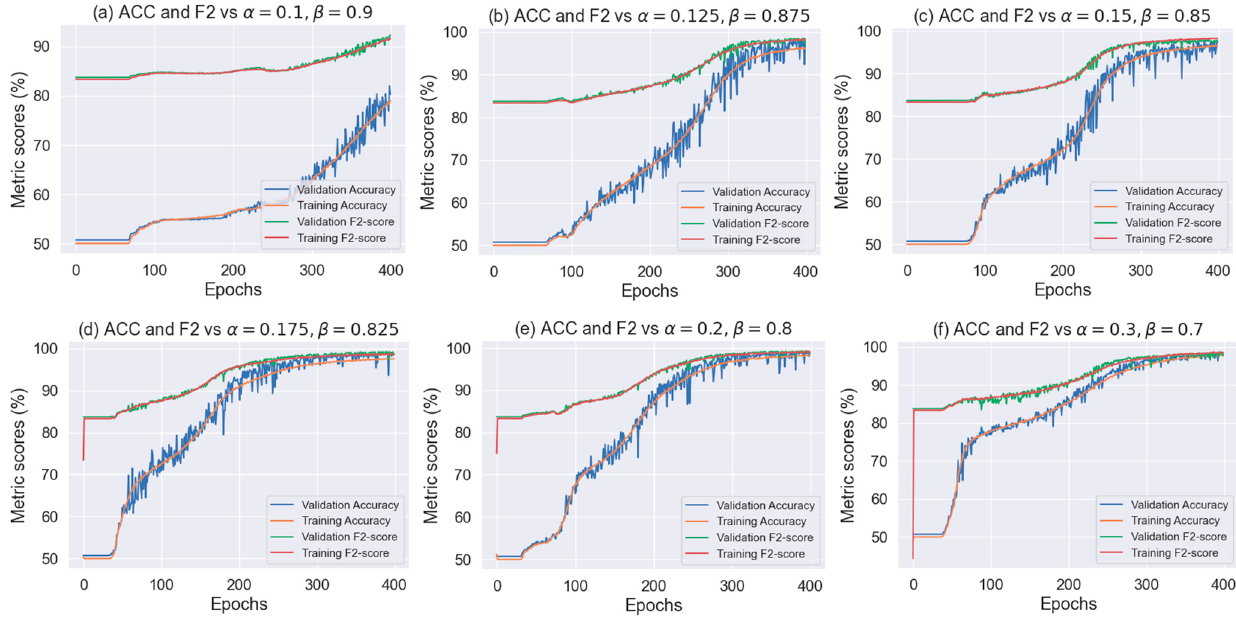
Figure 12. Accuracy, F2 ‐ score, and loss vs. α and β loss function parameters.